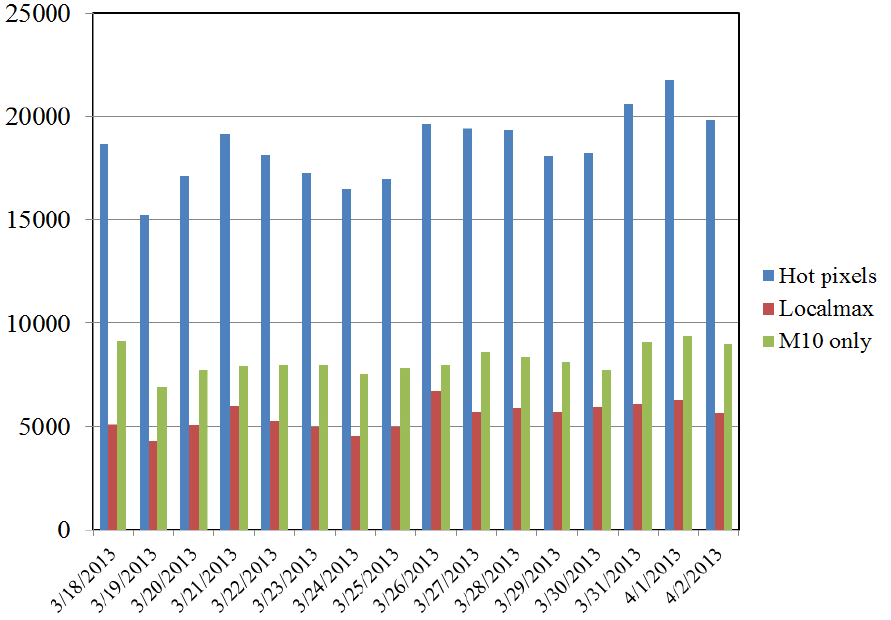
Figure 6. Tallies of Nightfire M10 hot pixels and local maxima for a sixteen day period starting 18 March 2013. The third column shows tallies of M10 detections that could not be confirmed with detection in at least one additional spectral band. These single band detections are treated as